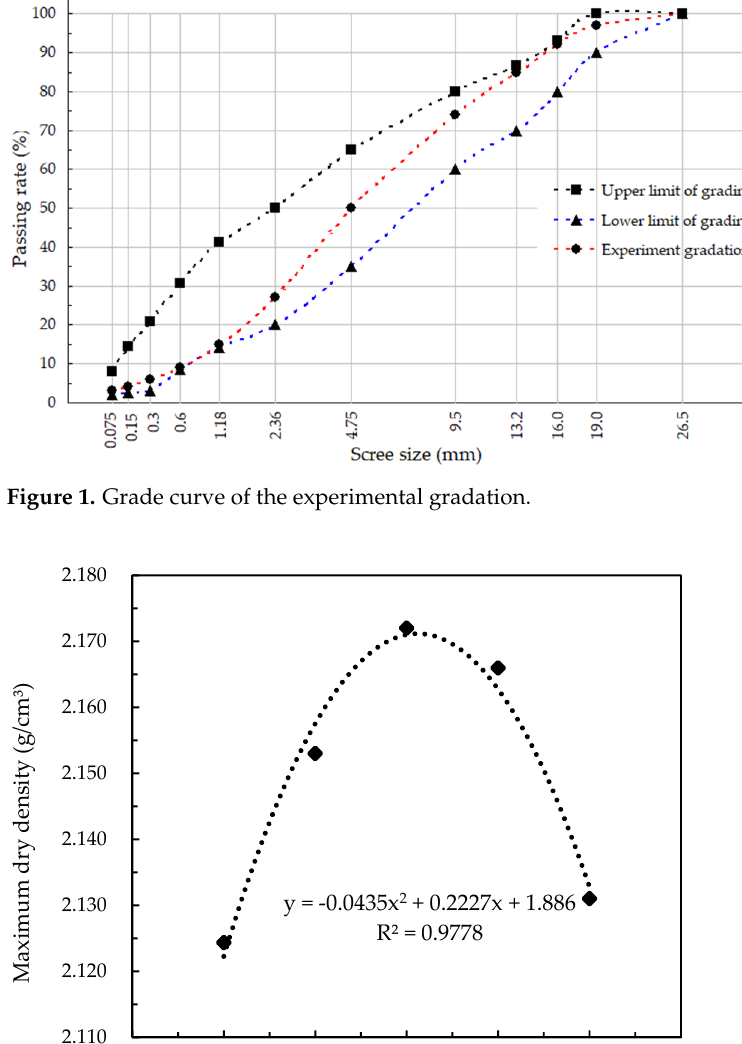
Figure 1. Grade curve of the experimental gradation.